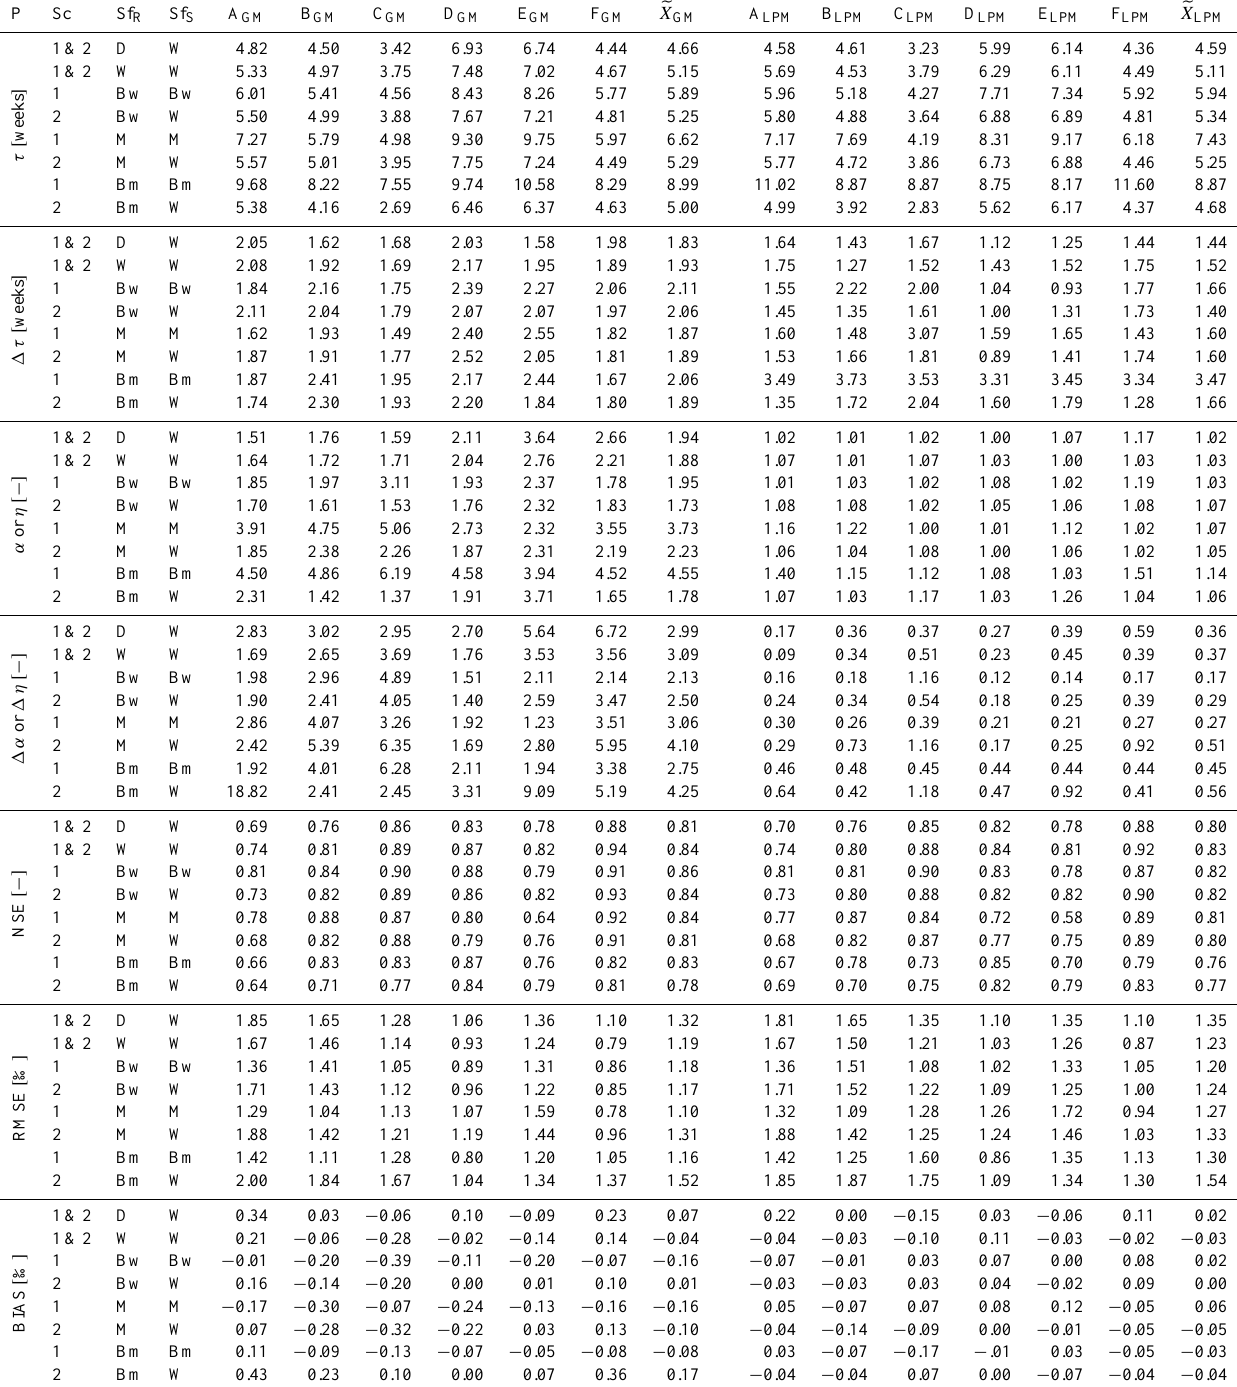
Table 1. Soil water simulation results using gamma and linear-piston models considering scenarios 1 and